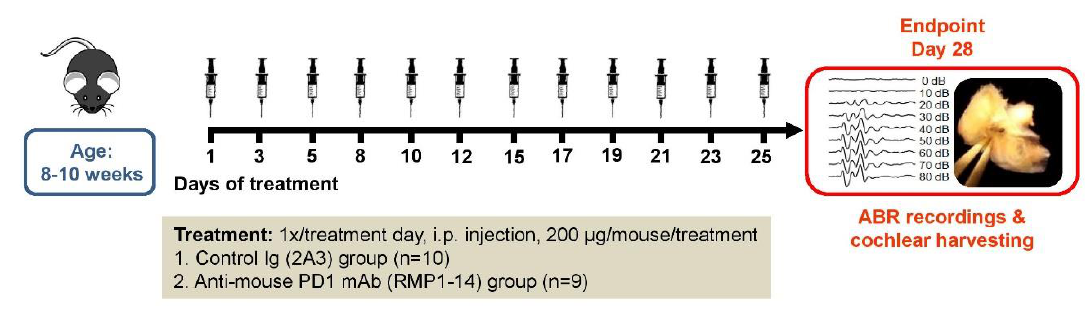
Figure 5. Flowchart of the experiments. C57BL / 6J mice received either an anti-mouse PD-1 (anti-PD-1 antibody) or an IgG2a isotype antibody (control) injection intraperitoneally three days per week for 4 weeks with a 2–3 days lag time between treatments. Syringes indicate the application of antibodies at the dose of 200 µ g / mouse / treatment. Measuring the function of hearing by auditory evoked potentials (ABR) and harvesting of cochlear tissues for morphological analysis were performed at the end of the treatment period.